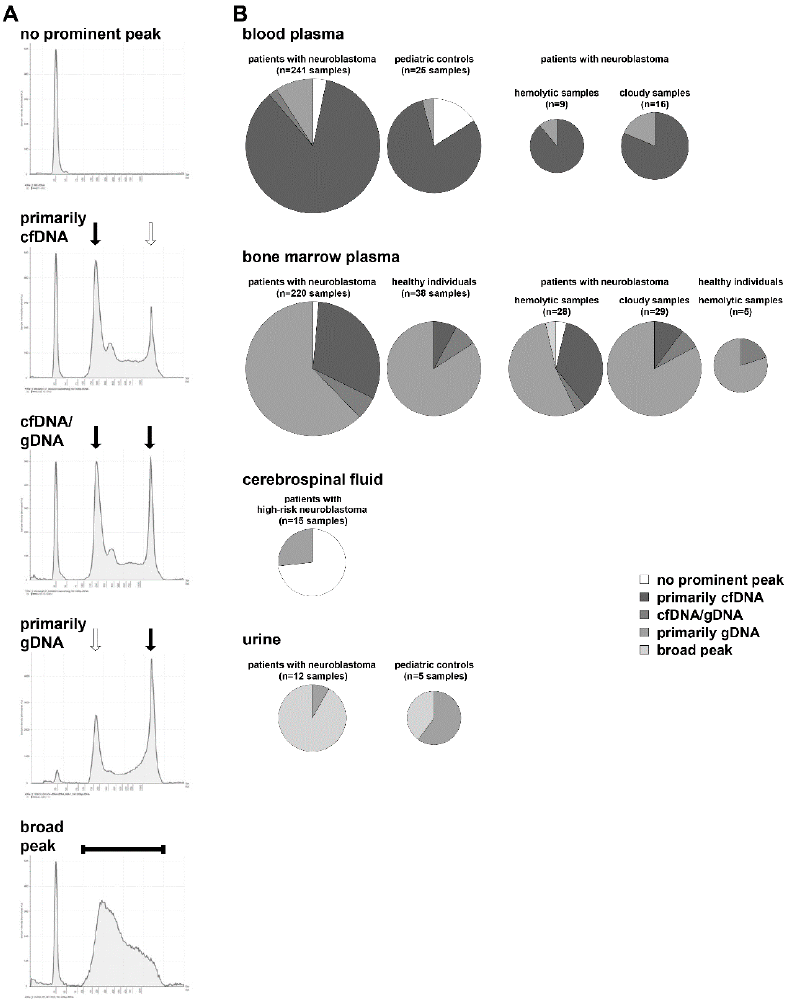
Figure 2. Analytical specification of cell-free DNA in biofluids. ( A ) DNA extracted from biofluids was analyzed using the cell-free DNA ScreenTape assay (Agilent) and the Agilent 4200 TapeStation System. Shown are five electropherogram profiles of cfDNA samples that represent differing sample quality dependent on the amount of high molecular weight material detected and the identification of the typical peak at approximately 170 bp representing the mononucleosome. Vertical arrows indicate peaks characteristic for the cfDNA fraction and/or the high molecular weight genomic DNA. The predominant DNA fraction is highlighted with a black arrow, whereas the smaller DNA fraction is marked with a white arrow. The broad peak characteristic in some electropherograms is indicated with a solid black horizontal line. ( B ) Multiple pie charts demonstrating the distribution of electropherogram profiles characterized by (i) no prominent peak, (ii) primarily cfDNA, (iii) similar amounts of cfDNA and high molecular weight genomic DNA, (iv) primarily high molecular weight genomic DNA and (v) a dominant broad peak among all blood plasma, bone marrow plasma, cerebrospinal fluid and urine samples collected from patients with neuroblastoma, pediatric controls and healthy